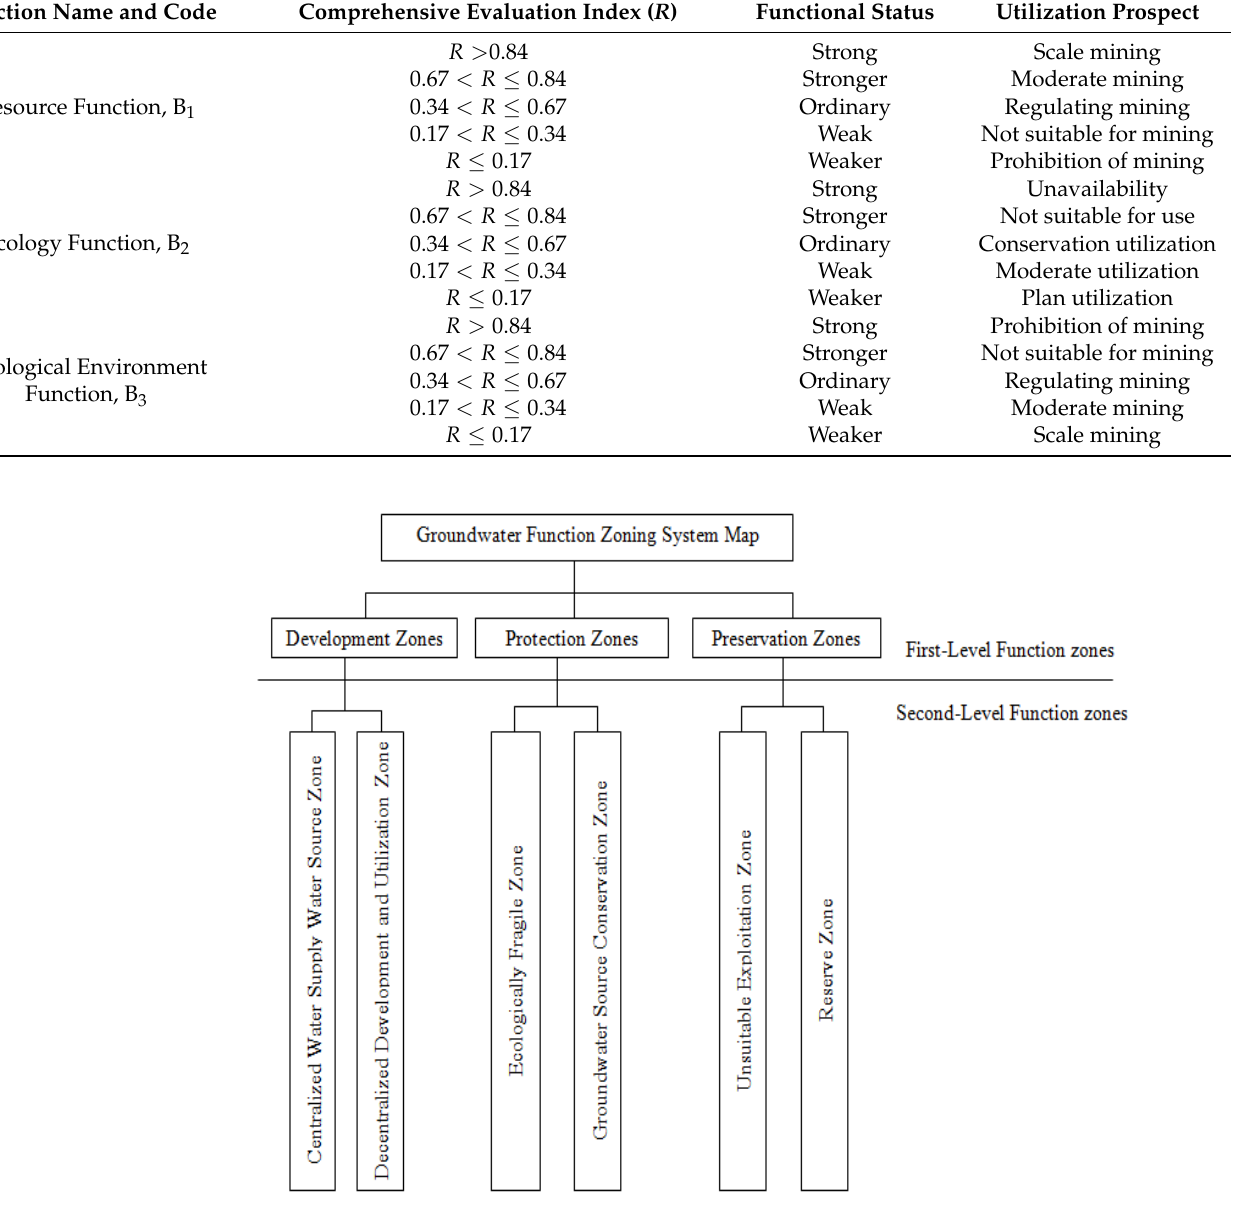
Figure 3. Functional zoning system of shallow groundwater in the study area.